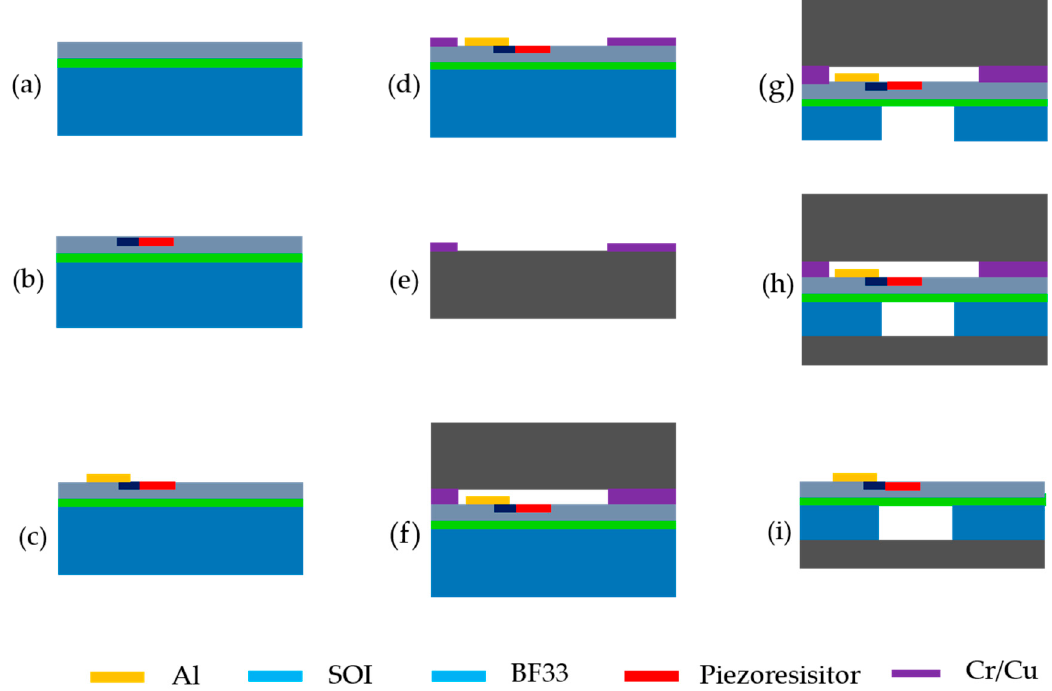
Figure 3. Manufacturing process of the proposed pressure sensor ( a ) SOI wafer, ( b ) ion impantation, ( c ) the electrode preparation, ( d ) sputtering deposition, ( e ) BF33 wafer, ( f ) bonding, ( g ) CMP and erching, ( h ) bonding and polishing, ( i ) dicing and